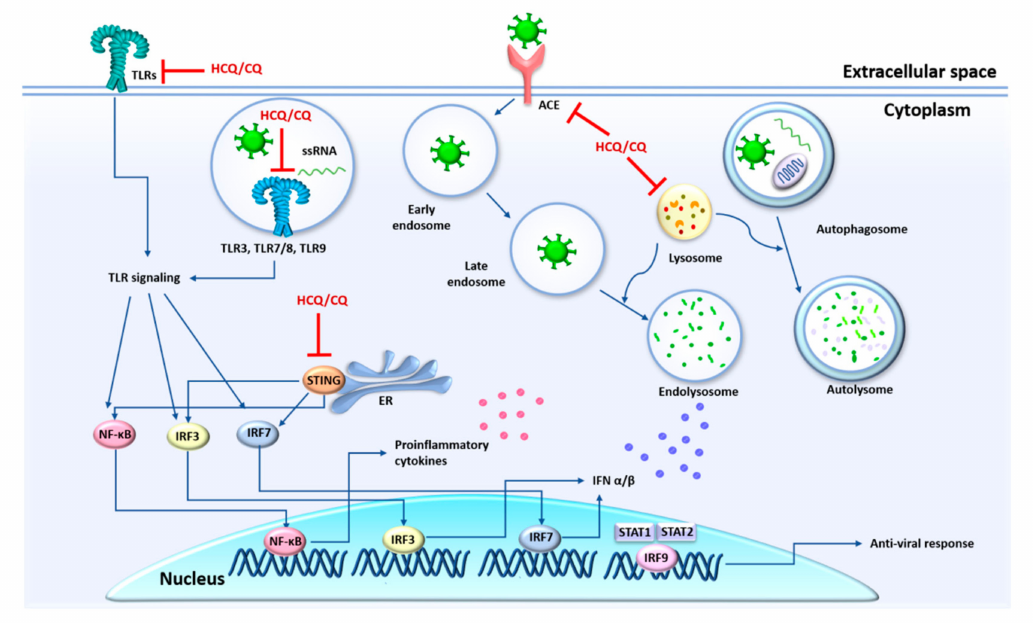
Figure 4. Main action mechanisms of chloroquine (CQ) and hydroxychloroquine (HCQ) related to antiviral and immunomodulators properties. By increasing the pH into lysosomes, CQ and HCQ interfere with cargo derived from endocytosis and / or from autophagic pathway. Moreover, CQ and HCQ prevent the PAMPs’ recognition by Toll-like receptors (TLRs). These drugs can inhibit the TLR and STING signaling, which automatically decreases the production of pro-inflammatory cytokines including the IFN